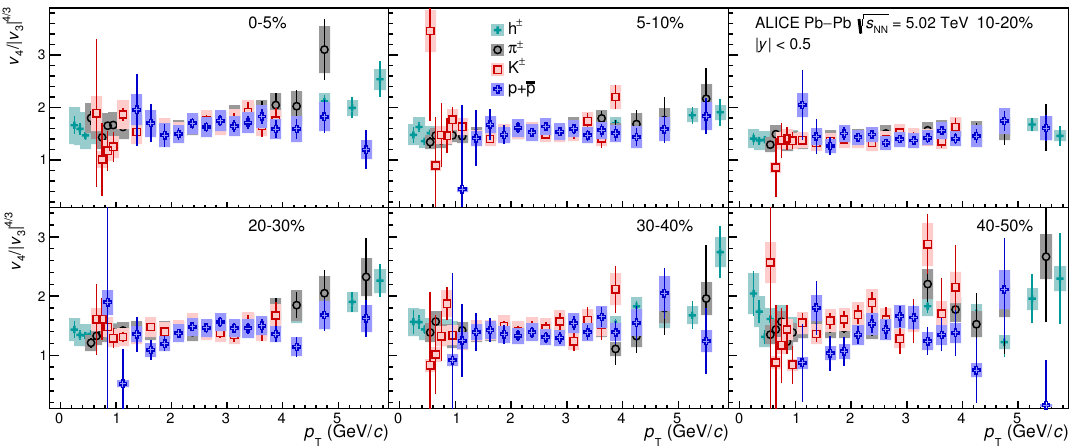
Figure 22 . (Colour online) Centrality dependence of v 4 = j v 3 j 4 = 3 for inclusive charged particles